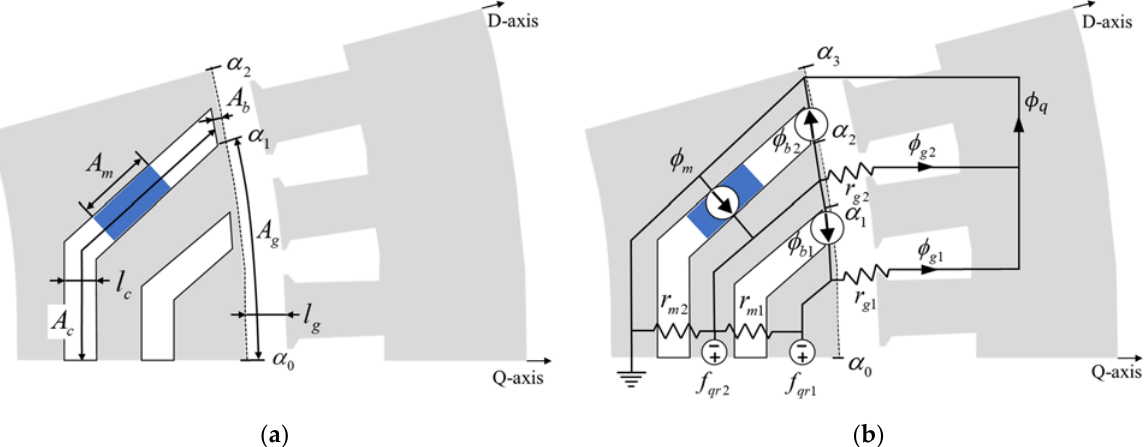
Figure 2. Magnetic equivalent circuit (MEC) for PM flux linkage. ( a ) Geometric definition for reluctances; ( b ) Q-axis linear MEC for PM flux linkage.